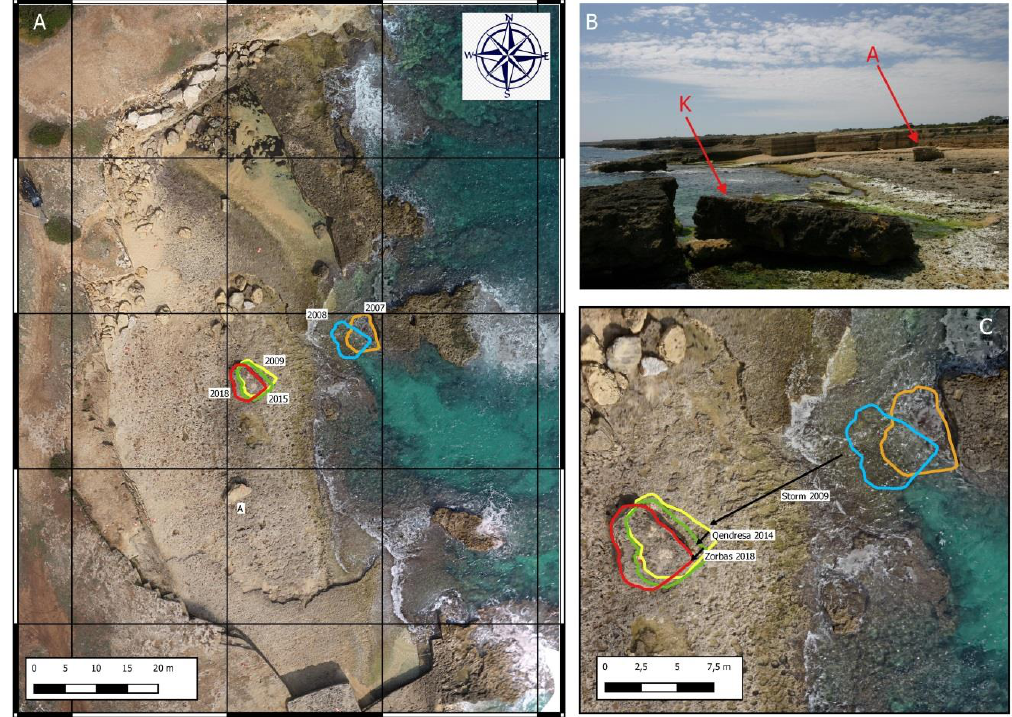
Figure 9. Boulders displacements during storm events; ( A ) Position of Boulders K and A from 2007 to 2018. ( B ) Position of Boulders K and A on 2008. ( C ) Displacements of Boulder K for the impact of the storms. The two medicanes transported inland dozens of small blocks, ranging in weight between 1 ton and 2